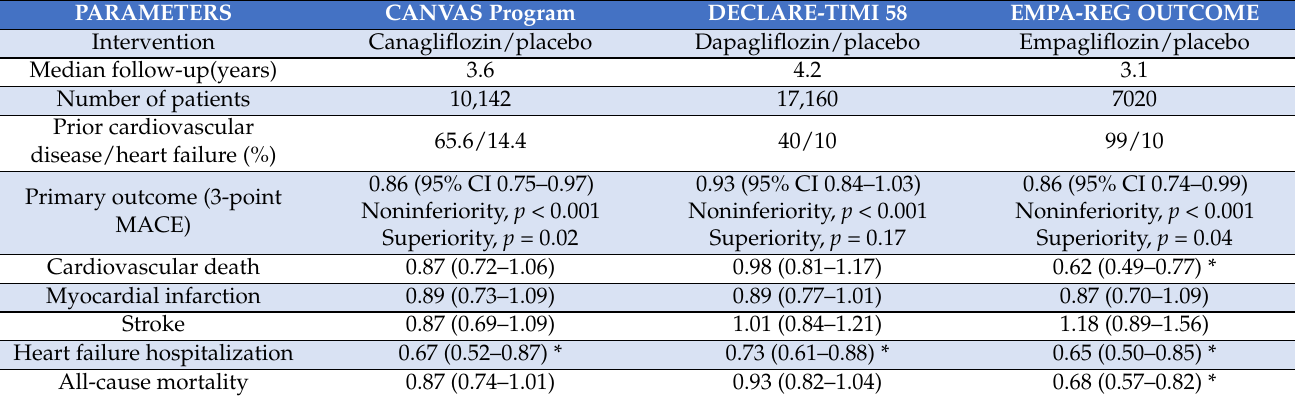
Table 1. Major Cardiovascular Outcome Trials with SGLT2